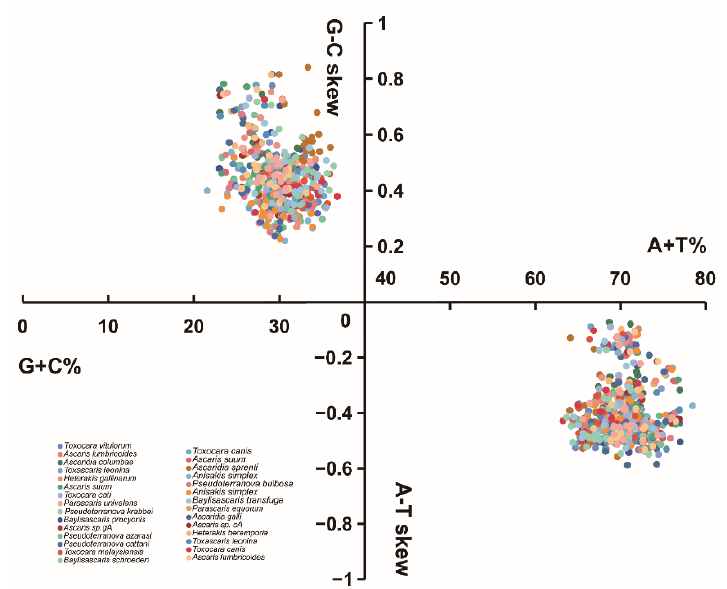
Figure 2. AT ‐ skew vs. GC ‐ skew of the different genetic positions of 29 mitogenomes. The X axis provides the A + T/G + C values, while the Y axis provides the skew values. For each species, the entire mitogenome, concatenated PCGs, concatenated tRNAs, concatenated rRNAs, the 1st, 2nd, 3rd, and 12 PCGs were separate calculated.